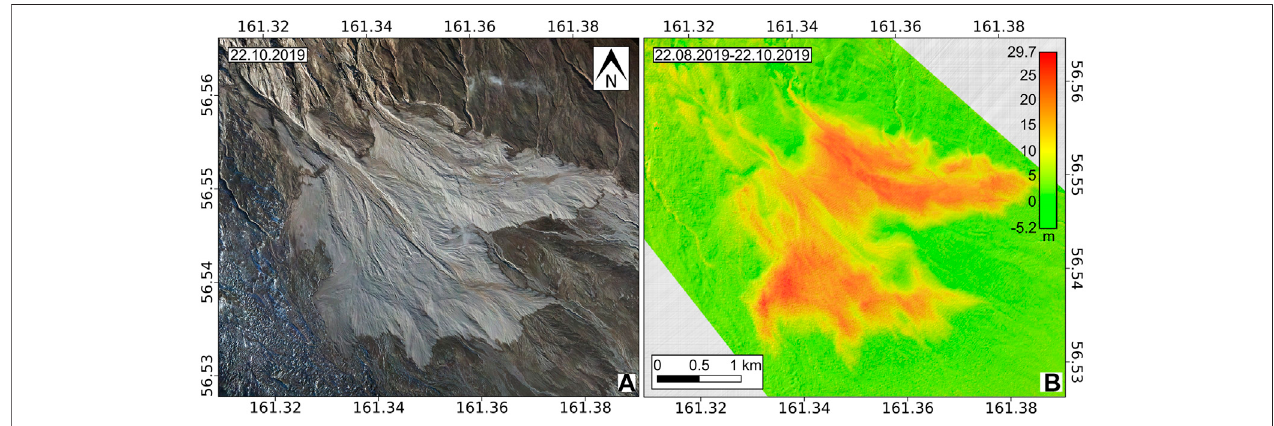
FIGURE 5 | Orthophoto (A) and height difference map (B) of the main PDC deposit fi eld from the August 29, 2019 eruption. The location of the fi eld is shown in Figure 1